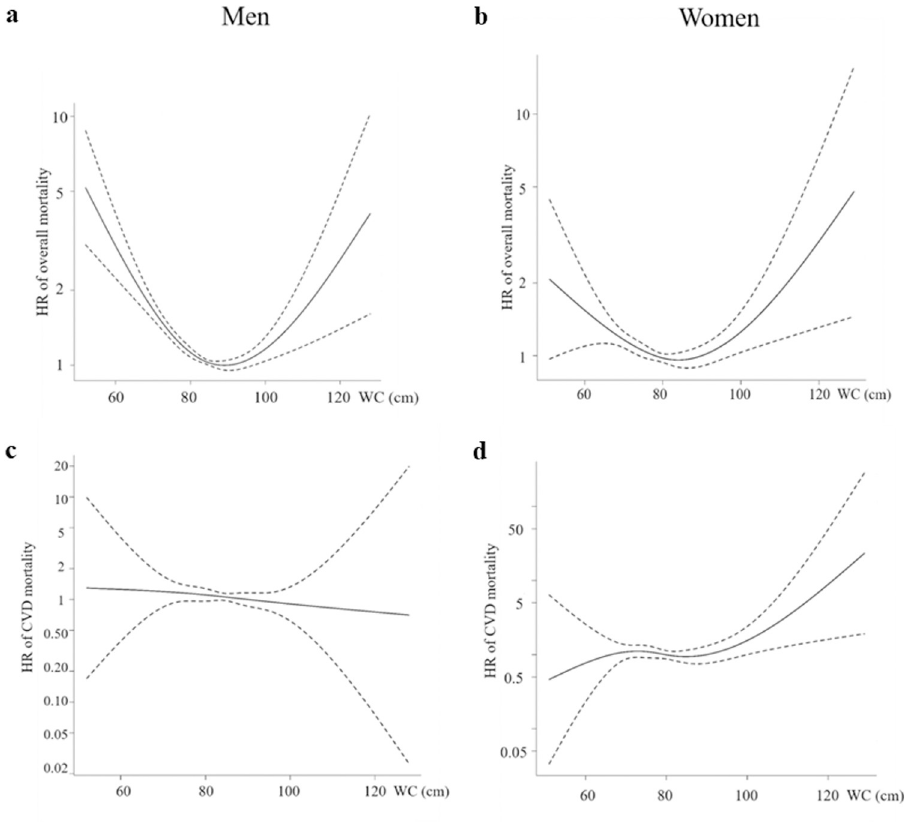
Fig 1. Association between waist circumference as a continuous variable and overall mortality and CVD mortality as a cubic spline after adjusting for age. For overall mortality and CVD mortality, the reference WC was set as < 80 cm. CVD, cardiovascular disease; HR, hazard ratio; WC, waist circumference.